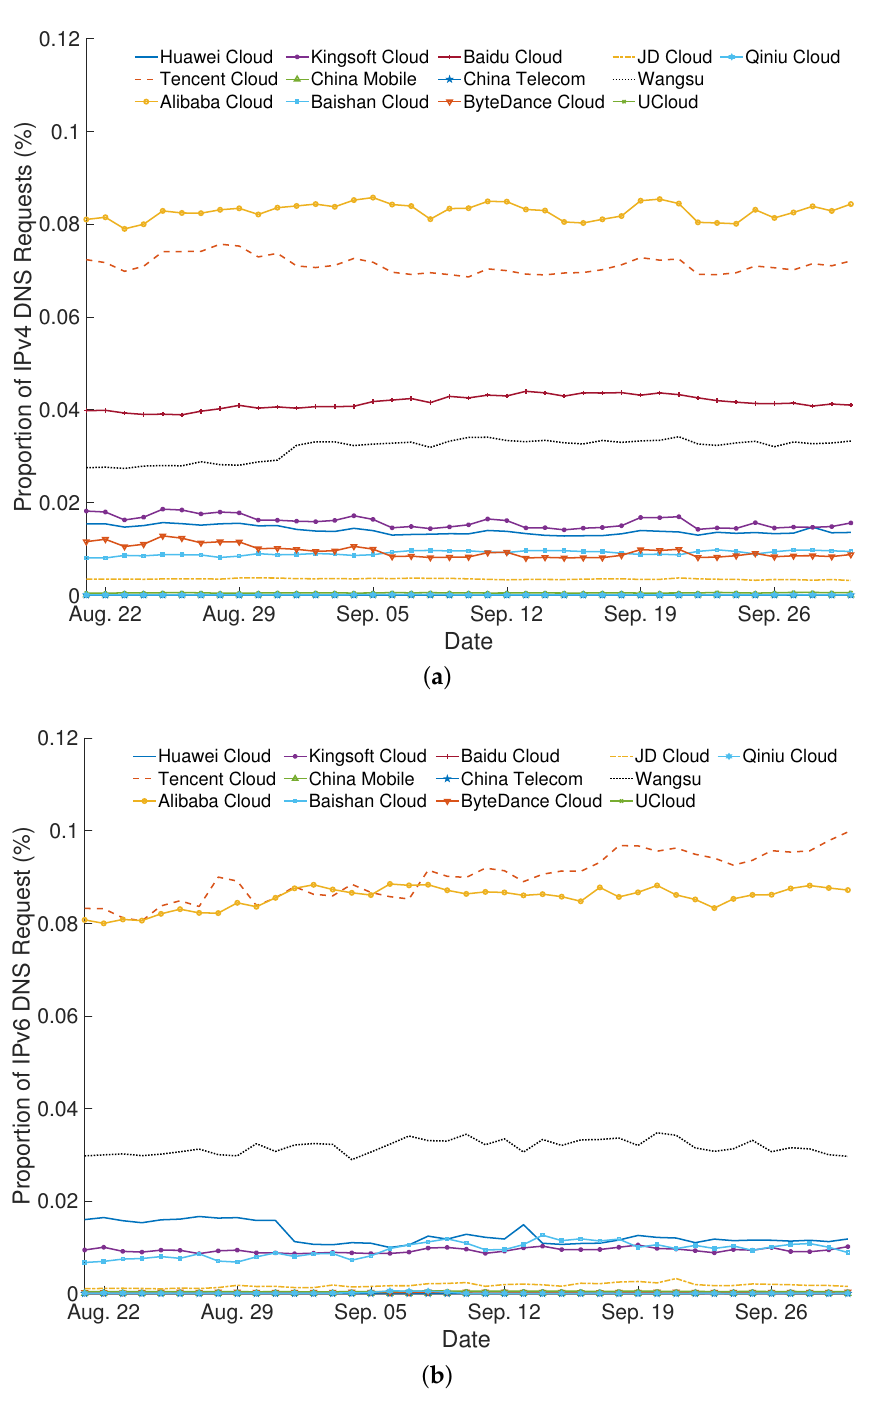
Figure 5. ( a ) Proportion of DNS requests using IPv4 over time for different CDN service providers. ( b ) Proportion of DNS requests using IPv6 over time for different CDN service